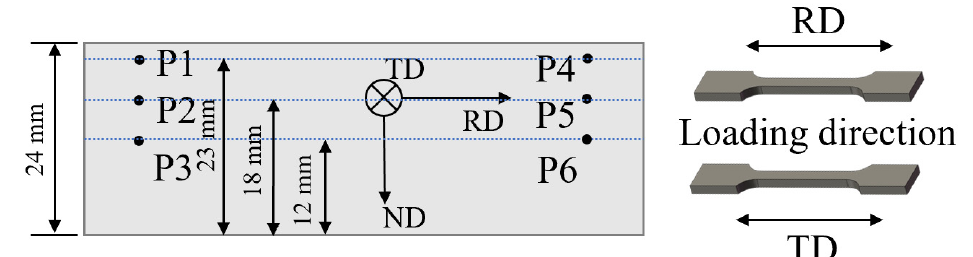
Figure 1. Identification of the positions of each specimen for tensile tests.